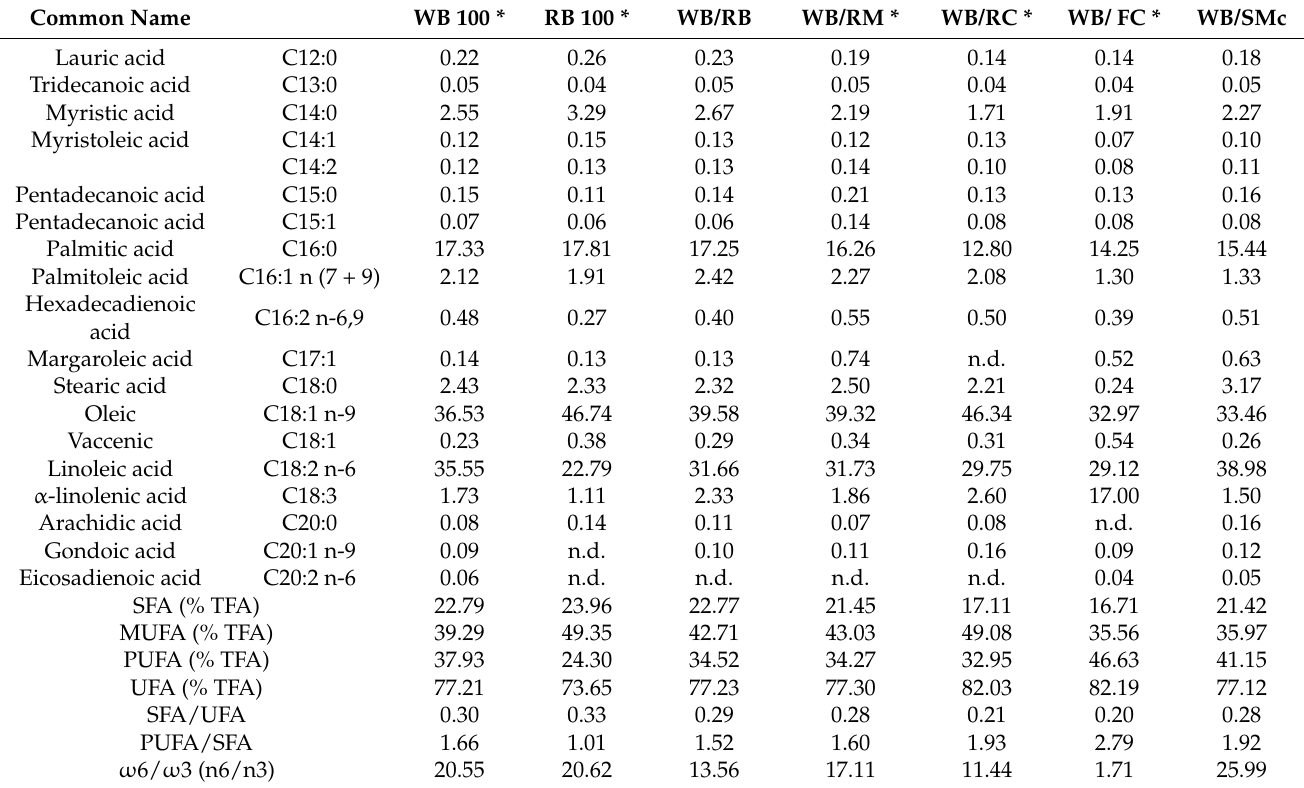
Table 5. Fatty acid profile in the total lipids (% of total identified fatty acid TFA) of mealworm larvae fed on different